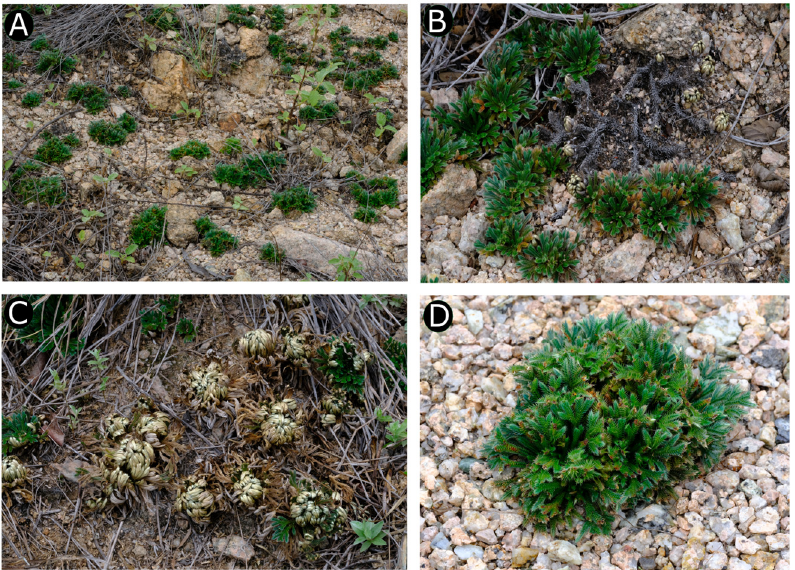
Figure 2. Habitat of Selaginella iridescens X. C. Zhang and Y. R. Wang sp. nov. ( A ) Habitat; ( B ) prostrate stems; ( C ) semi-dry individuals; ( D ) fresh individuals.